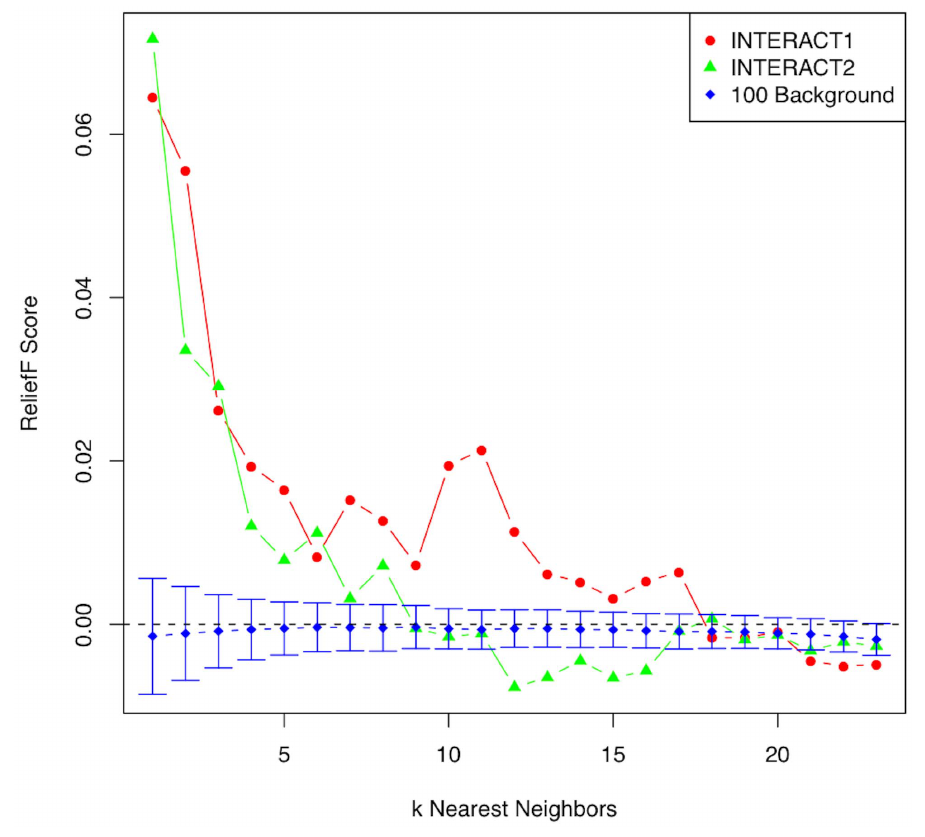
Figure 3. Illustration of the effect of the number of nearest neighbors (k) on the Relief-F score for two interacting transcripts (red circles and green triangles) from one of the simulated data sets. A lower k is optimal for interacting transcripts. For larger k, Relief-F converges to a univariate attribute estimator (myopic) and the scores of the interacting transcripts tend toward zero because they have no main effect. For comparison, the average scores and 5 th and 95 th percentiles for 100 random null transcripts (blue diamonds) in the data set are plotted versus k. The Relief-F scores for noise genes are low and relatively unaffected by the value of k.